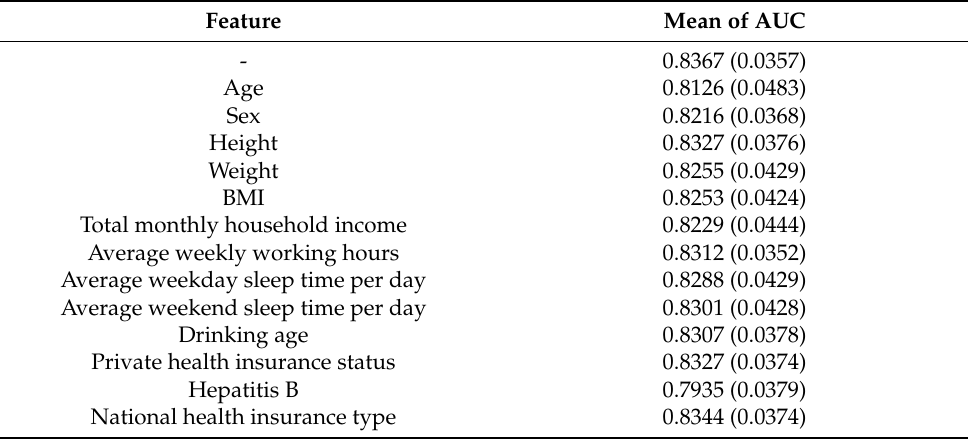
Table 9. Sensitivity analysis result of the risk association model for liver cancer. Standard deviation is presented in parentheses.